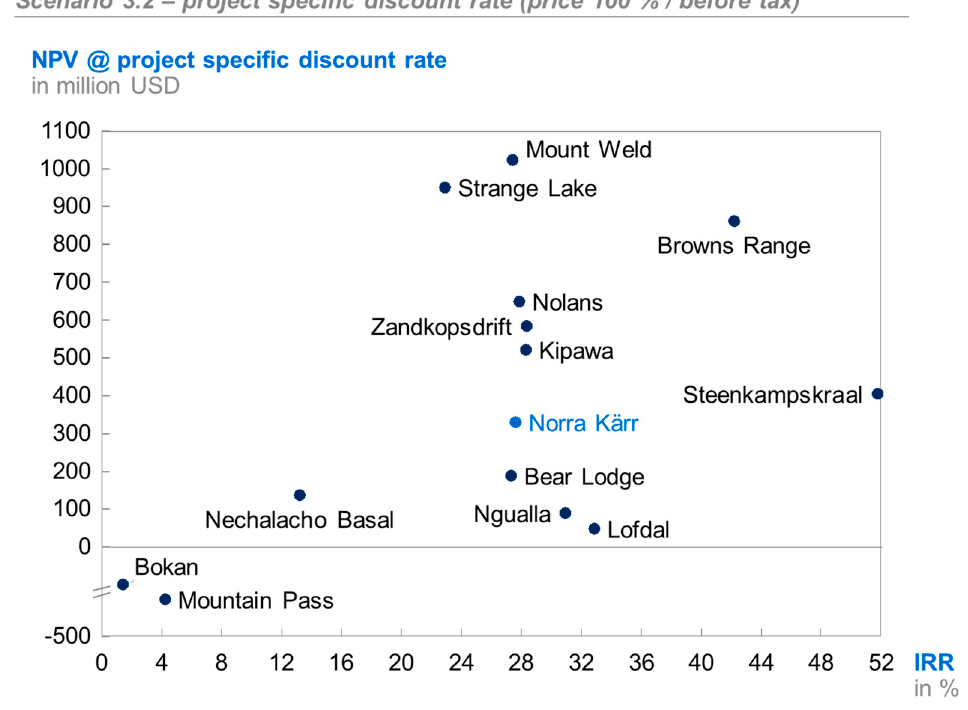
Figure 8. Results of the DCF model with project-specific discount rates (pre-tax) with a 100% price increase for critical REO.